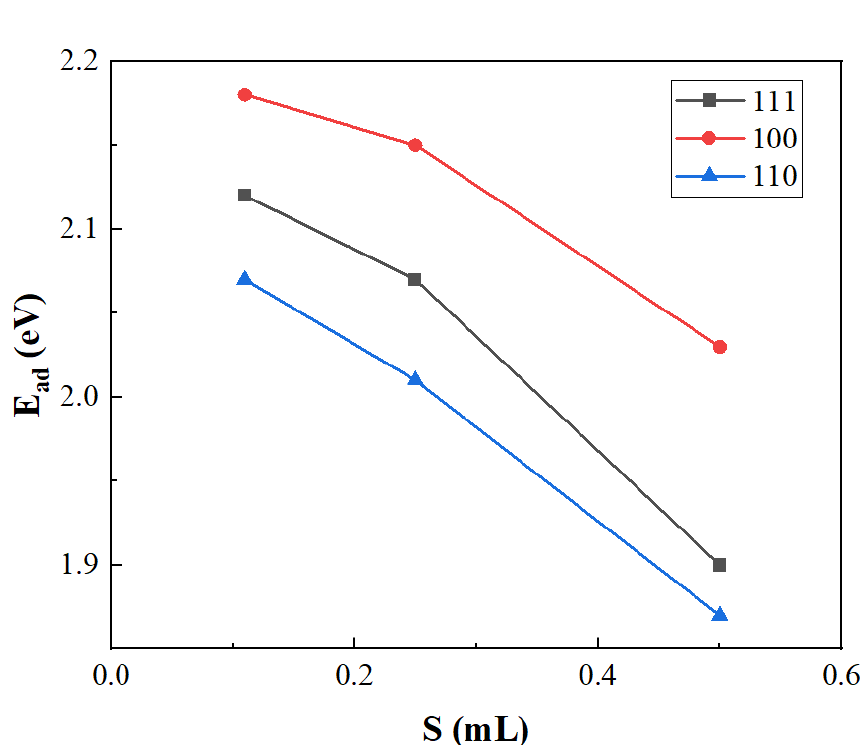
Figure 5. The variations of adsorption energy with coverage on three crystal surfaces.